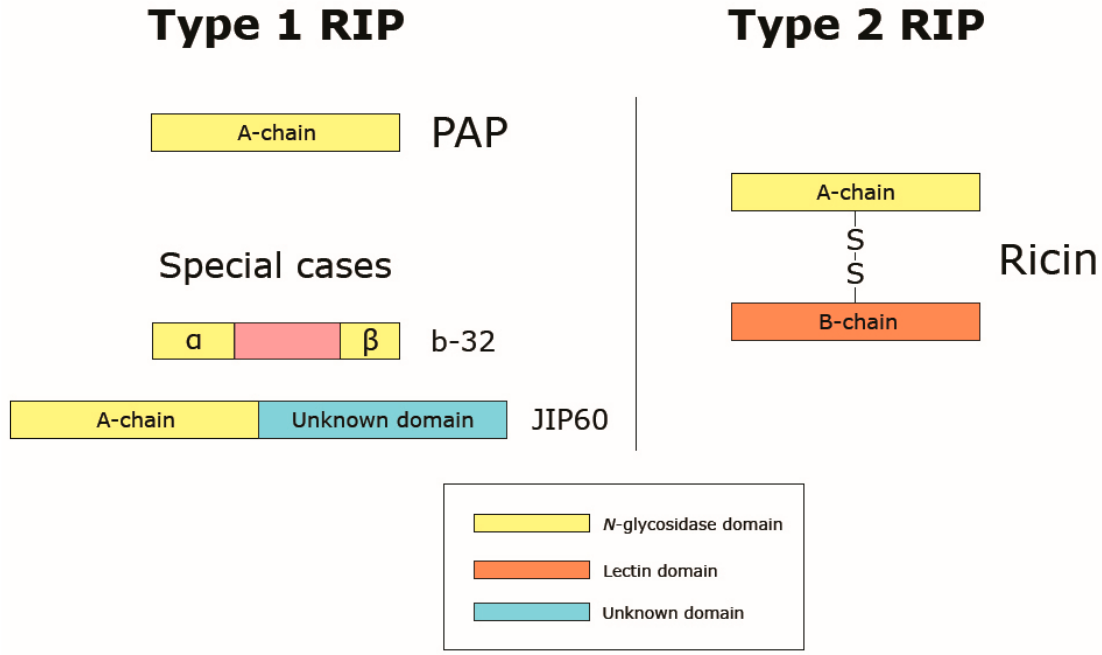
Figure 2. Schematic representation of the molecular structure of type 1 and type 2 RIPs. Special cases of type 1 RIPs refer to b-32 and JIP60 from maize and barley, respectively [98,99]. b-32 is synthesized in the form of proenzyme which becomes active only after the removal of a short internal peptide segment, leaving two segments of 16.5 and 8.5 kDa. JIP60 contains an active chain similar to classical type 1 RIP, which is linked to another segment of similar size but unknown function. The schematic representation of type 2 RIPs relates to mature ricin.